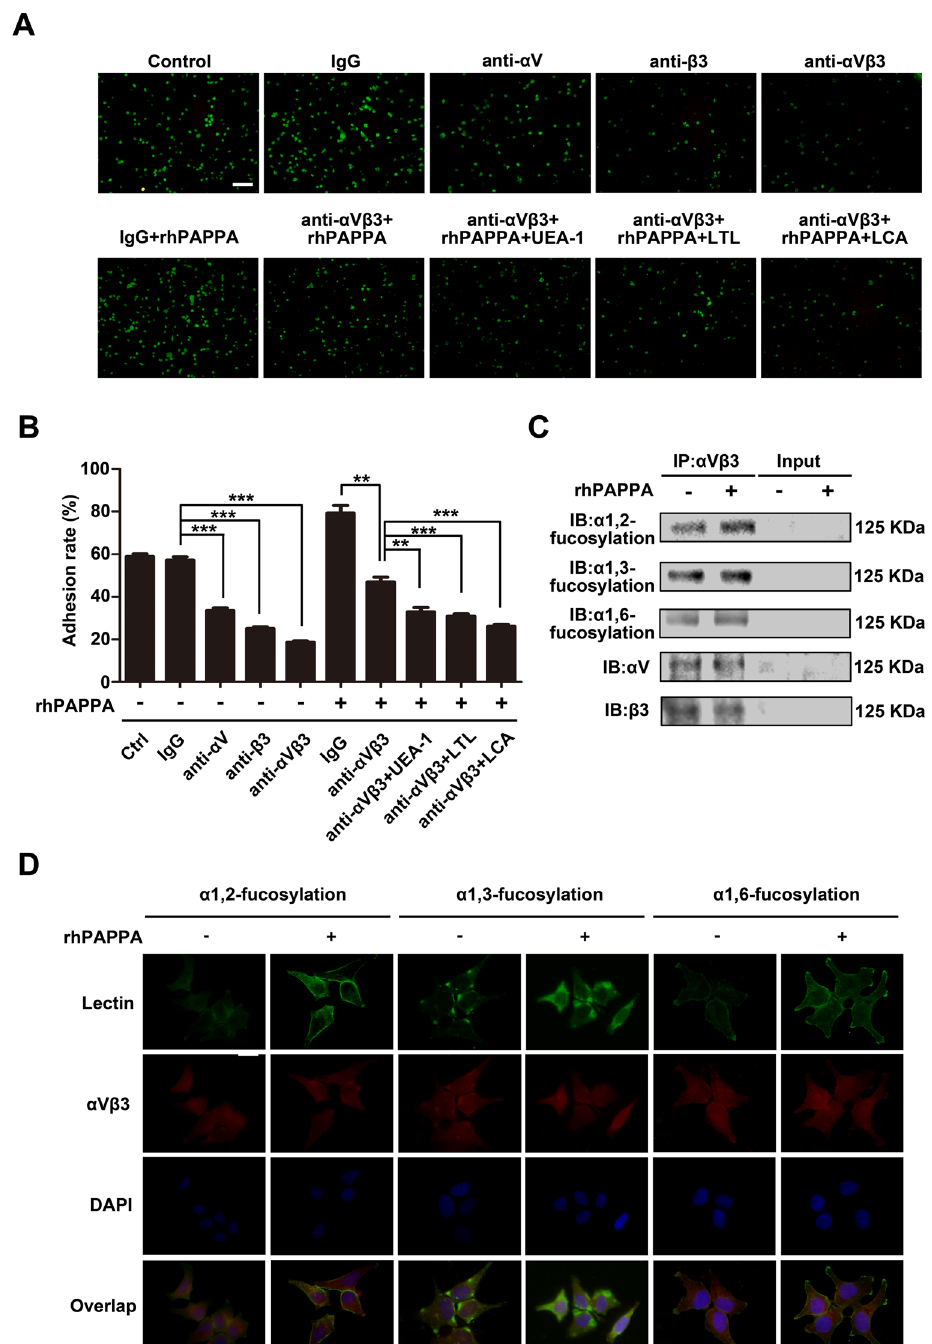
Figure 6. rhPAPPA promotes endometrium receptivity by up-regulating the specific fucosylation of integrin α V β 3. ( A ) Adhesion of JAR cells to Ishikawa cells pre-treated without (a) untreated control, or with (b) IgG, (c) anti- α V, (d) anti- β 3, (e) anti- α V β 3, (f) rhPAPPA + IgG, (g) rhPAPPA + anti- α V β 3, (h) rhPAPPA + anti- α V β 3 + UEA-1, (i) rhPAPPA + anti- α V β 3 + LTL, (j) rhPAPPA + anti- α V β 3 + LCA. ( B ) Adhesion rate of JAR cells to pre-treated Ishikawa as indicated is shown in the histogram. ( C ) Integrin α V β 3 was immunoprecipitated from the whole-protein lysate of untreated control and rhPAPPA-treated Ishikawa cells. The specific N-fucosylation of α V β 3 was detected by Western blotting. α V and β 3 were detected to show the loading protein amount. Input showed the efficiency of immunoprecipitation. ( D ) Immunofluorescence and Lectin staining detected the expression and cellular localization of the specific fucosylation and α V β 3 after rhPAPPA treatment. Green, α 1,2-, α 1,3-, or α 1,6-fucosylation; red, α V β 3; yellow (overlay), co-staining of α 1,2-, α 1,3-, or α 1,6-fucosylation with α V β 3. DAPI (blue) was used for nuclear staining. The bar represents 50 μ m. ** p < 0.01, *** p < 0.001. The data were presented as the means ± SEM of three independent